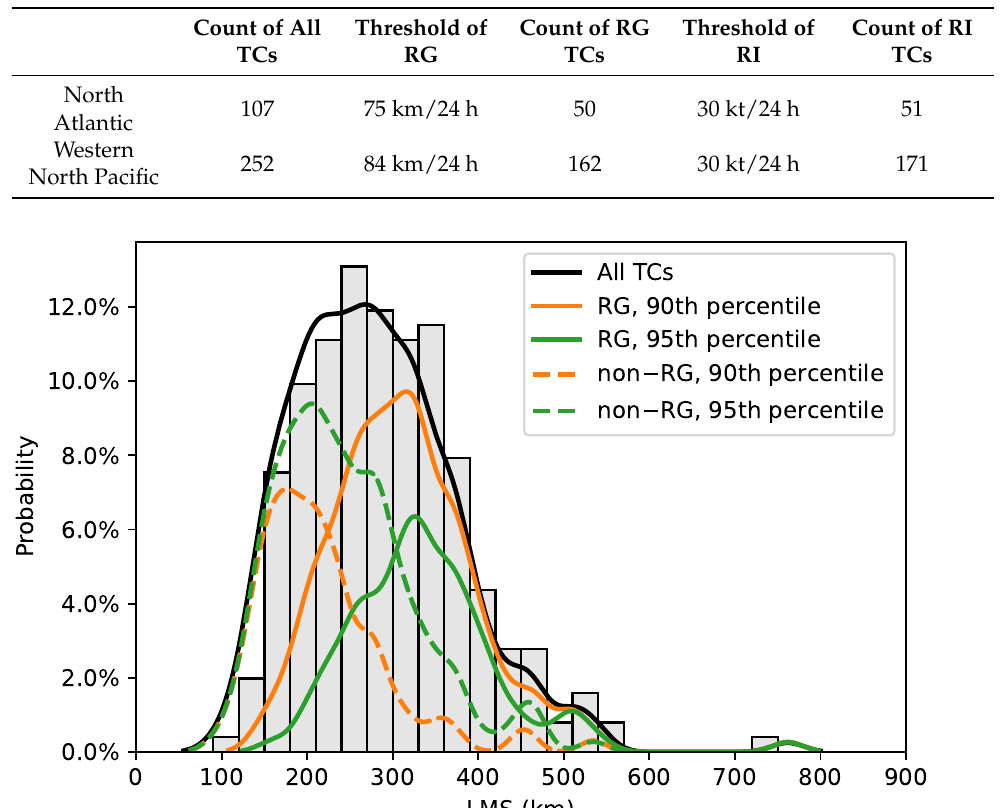
Table 1. Count of rapid growth (RG) and rapid intensification (RI) TCs for the north Atlantic and western north Pacific.